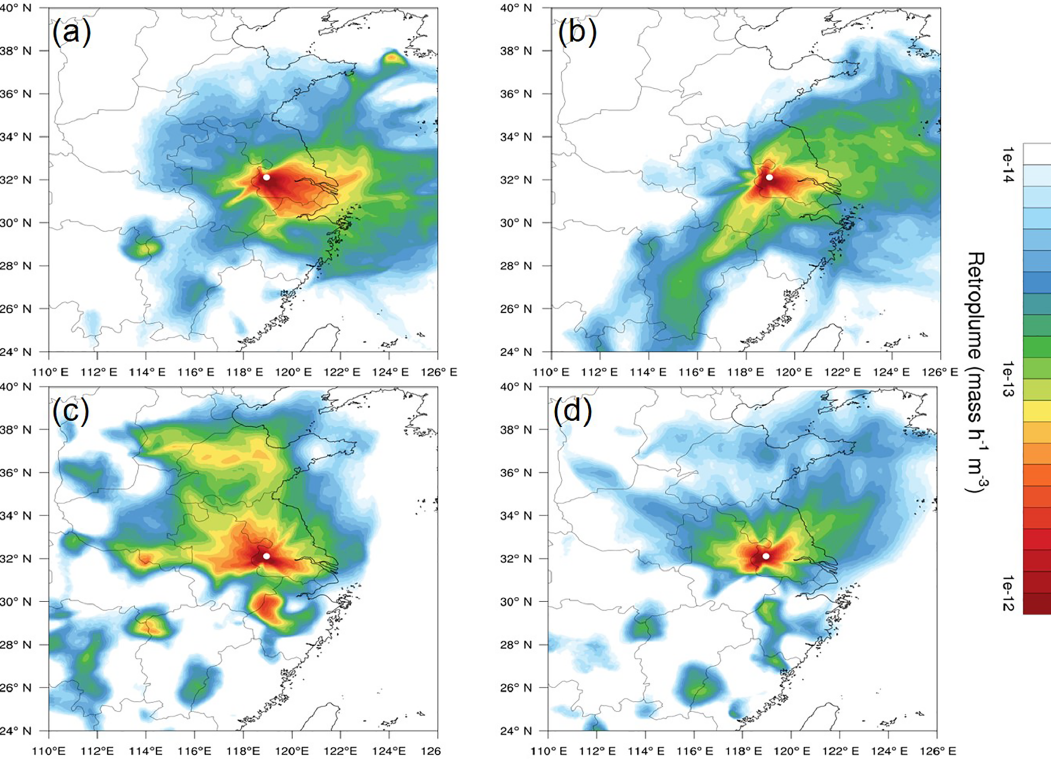
Figure 7. The averaged retroplumes (i.e., 100m footprint) of the selected events: (a) top 25% nitrate concentrations in summer, (b) bottom 25% nitrate concentrations in summer, (c) top 25% nitrate concentrations in winter and (d) bottom 25% nitrate concentrations in winter.